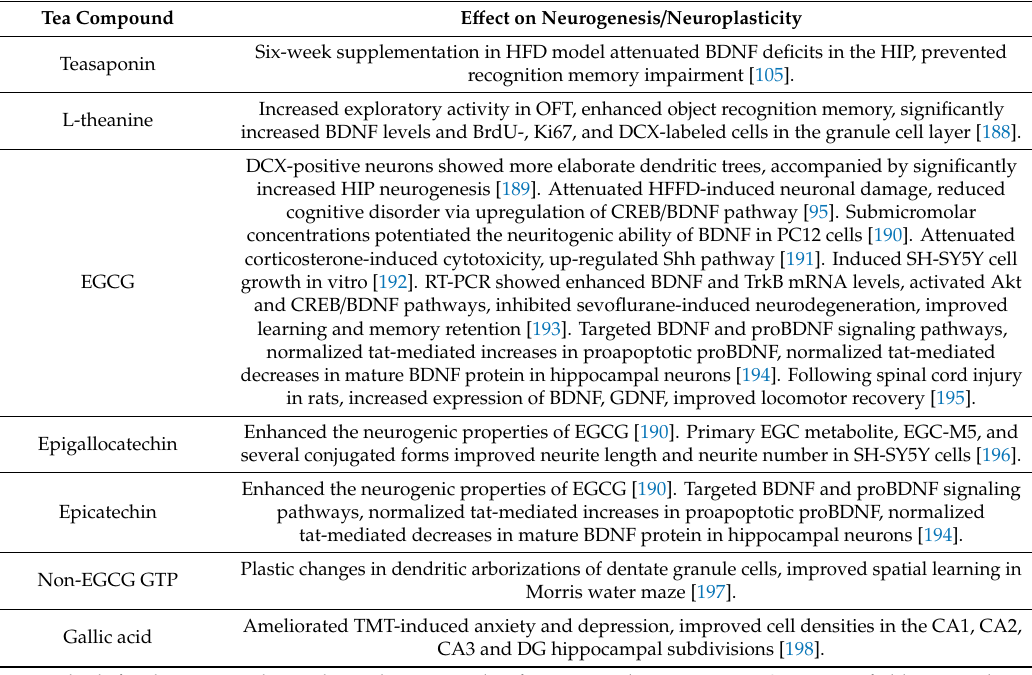
Table 4. Various tea compounds and their e ff ects on BDNF, neurogenesis and neuroplasticity. Tea Compound E ff ect on Neurogenesis / Neuroplasticity Six-week supplementation in HFD model attenuated BDNF deficits in the HIP, prevented Teasaponin recognition memory impairment [105]. L-theanine